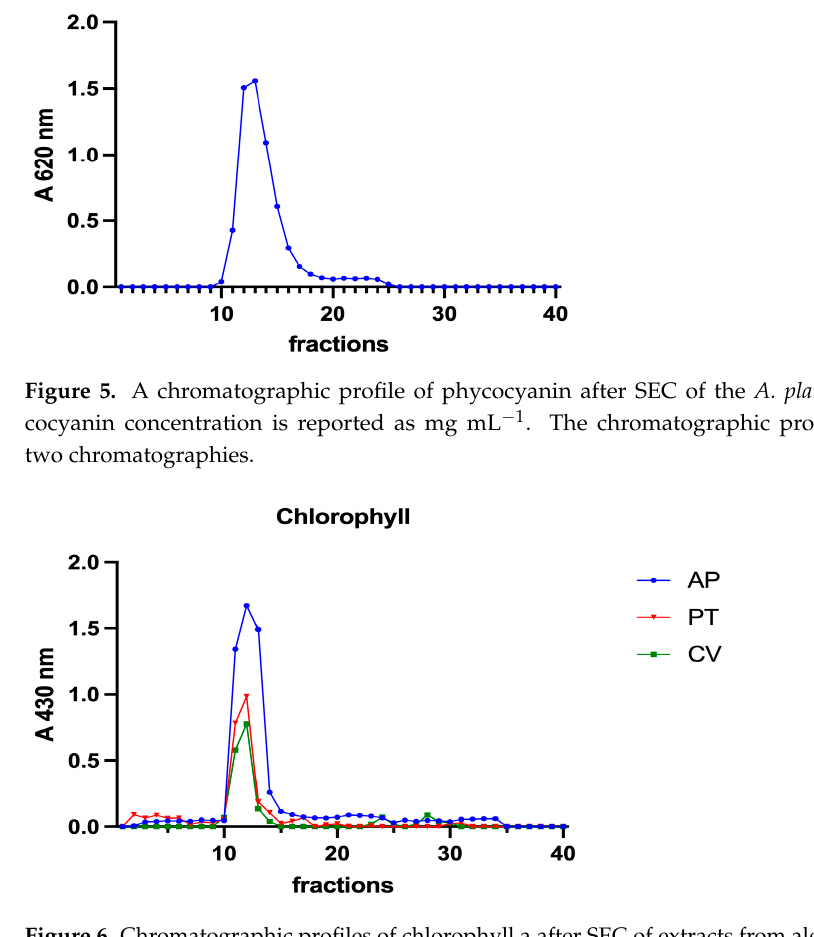
Figure 6. Chromatographic profiles of chlorophyll a after SEC of extracts from algal biomass. Chloro- phyll a was detected at 430 nm. Each chromatographic profile is the mean of two